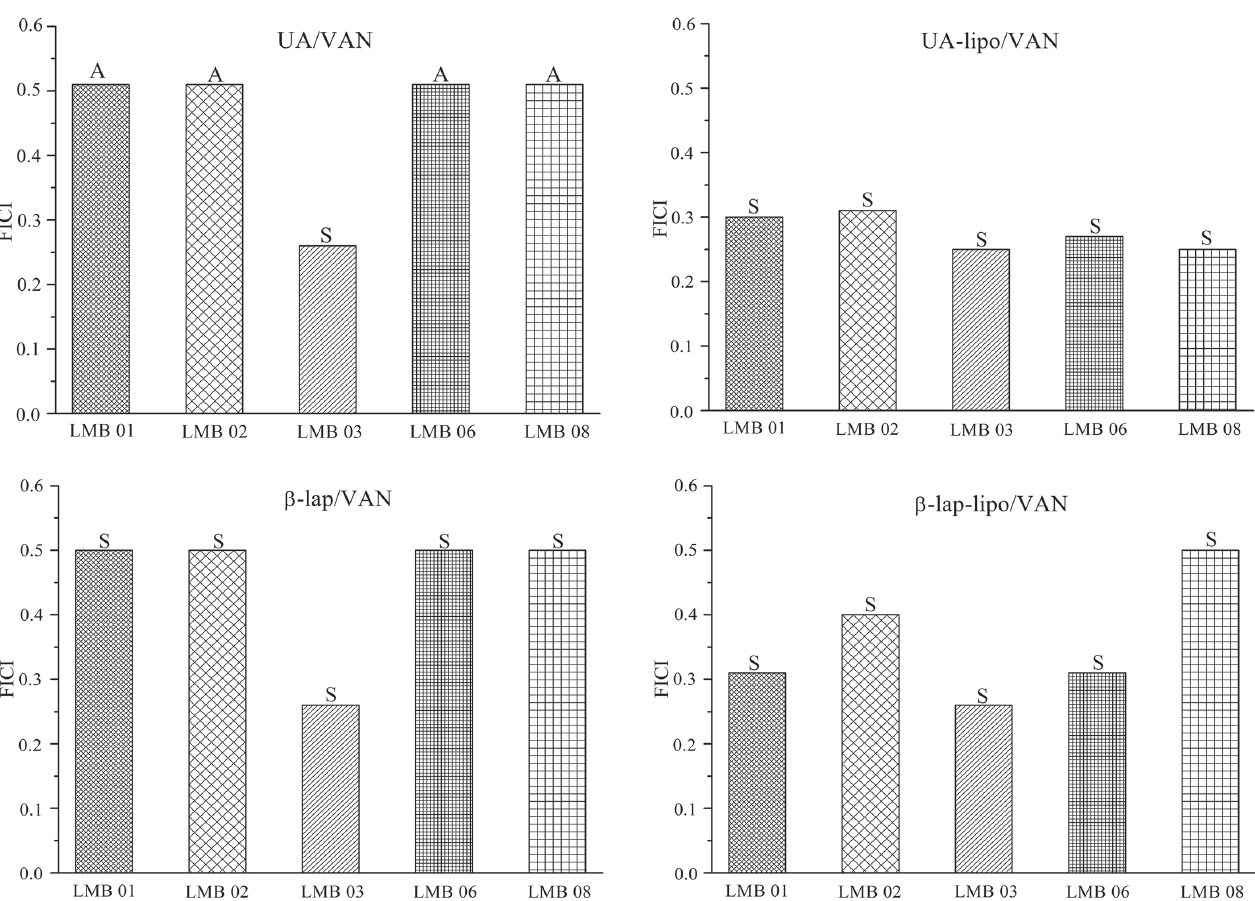
FIGURE 1 - In vitro interactions between VAN and UA, UA-lipo, β-lap or β-lap-lipo against MRSA clinical isolates using checkerboard method. FICI: Fractional Inhibitory Concentration Index; LMB: Laboratório de Microbiologia e Imunologia; VAN: vancomycin; UA: usnic acid; β-lap: β-lapachone; UA-lipo: UA-loaded liposomes; β-lap-lipo: β-lap-loaded liposomes; A: additive interaction; S: synergistic TABLE II - In vitro interactions between VAN and UA, UA-lipo, β-lap or β-lap-lipo using Etest MIC (µg/mL) VAN VAN MRSA strains